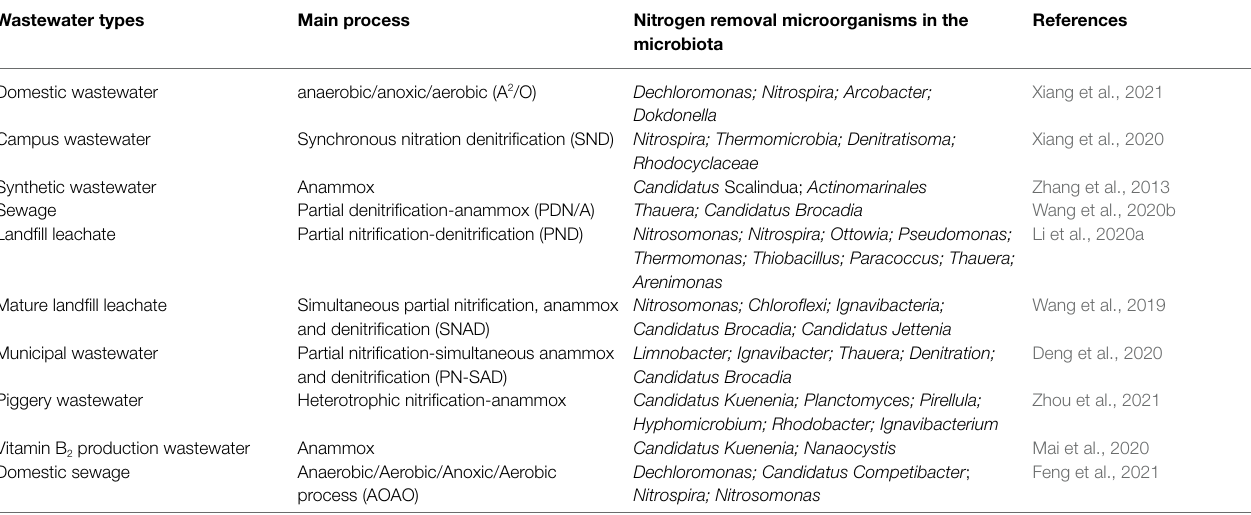
TABLE 1 | Biological nitrogen removal processes for different wastewater